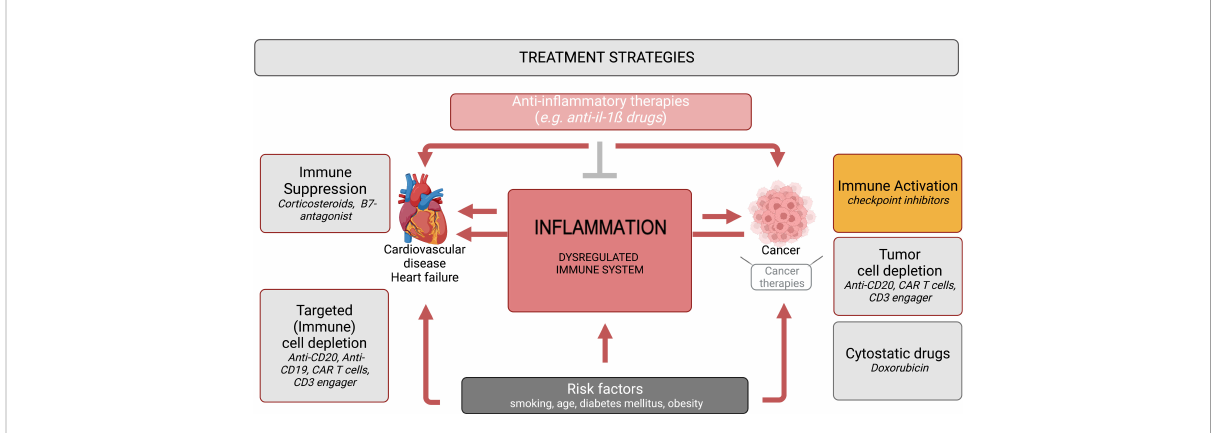
FIGURE 1 Immuno-cardio-oncology – anti-in fl ammatory and immunomodulatory strategies in CVD/heart failure and cancer. In fl ammation and a dysbalanced immune system, provoked by risk factors such as smoking, age, diabetes mellitus and obesity, are common triggers in the pathogenesis of cancer and CVD/heart failure. Anti-cancer therapies comprise strategies directed to activate the immune response e.g. checkpoint inhibitors, to deplete tumor cells (anti-CD20, CAR T cells, CD3 engager), and cytostatic drugs e.g. doxorubicin, of which checkpoint inhibitors, CAR T cells and doxorubicin provoke cardiac in fl ammation. In contrast, immunosuppressive therapies like corticosteroids and B7- antagonists are used for the treatment of CVD and heart failure. Repurposed (immune) cell depletion strategies (anti-CD20, CD19 antibodies, CAR T cells, CD3 engager) have entered the cardiology fi eld. Anti-in fl ammatory therapies (e.g. anti-IL-1ß drugs) are under investigation for the treatment of cancer, cancer therapy-related in fl ammation and CVD/heart